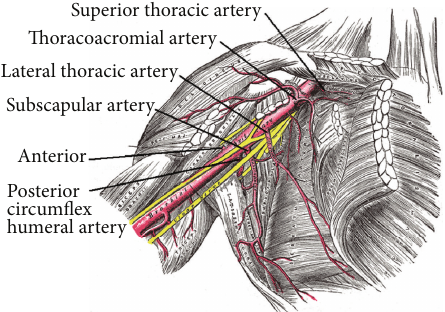
Figure 4: Review of axillary artery anatomy with preferred access site being medial to the lateral thoracic artery. Source: see [19]. Axillary artery is divided into three branches based on its location relative to the pectoralis minor muscle. The first, second, and third parts are medial, posterior, and lateral to the pectoralis minor muscle, respectively. The branches of the axillary artery supply the arm and the muscles of thorax and scapular region and this region is well collateralized providing circulation to the arm from arteries that arise from dorsal and suprascapular artery. Given the abundance of collateral circulation, axillary artery can be and is used forarterialcannulationduringcardiacsurgery,withoutendangering the circulation to the arm, especially if the access point is medial to the origin of the lateral thoracic artery, given its anastomosis with the intercostal and the internal mammary artery.